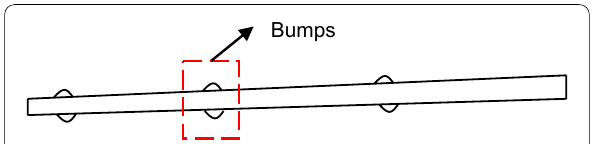
Fig. 1 The shape of radial bamboo strip close to top of bamboo